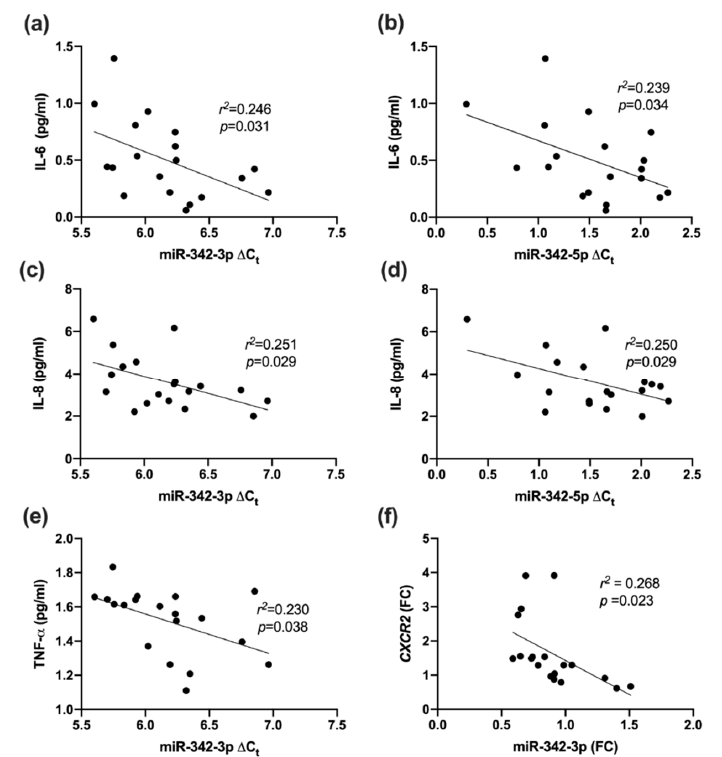
Figure 2. Correlation between miR-342-3p/-5p and inflammatory markers in type 1 diabetes and healthy controls combined. ( a ) miR-342-3p and IL-6; ( b ) miR-342-5p and IL-6; ( c ) miR-342-3p and IL-8; ( d ) miR-342-5p and IL-8; ( e ) miR-342-3p and TNF- α ; ( f ) miR-342-3p and chemokine receptor type 2 ( CXCR2) . FC—fold